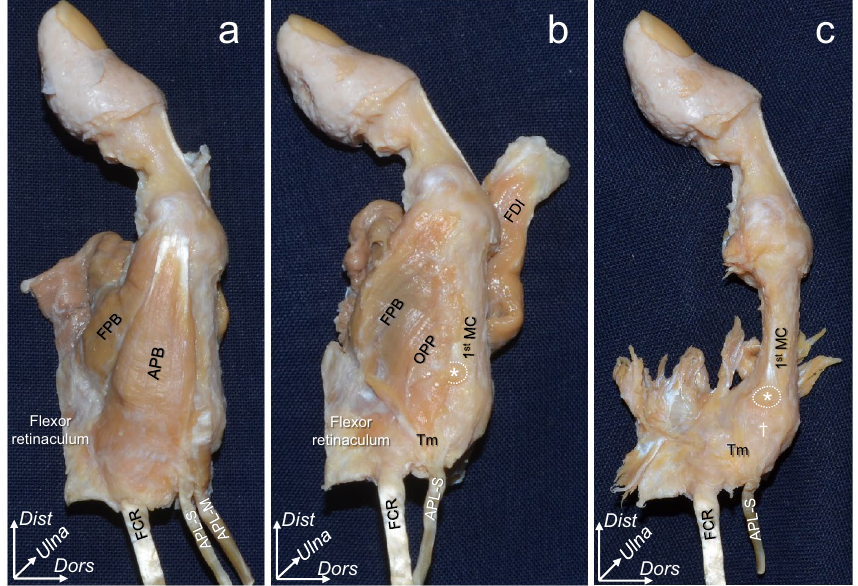
Figure 4. Macroscopic analysis of the radial aspect of the trapeziometacarpal joint. The photographs in Fig. 3 show the radial aspect (right thumb). The layered relationships among the abductor pollicis brevis (APB), opponens pollicis (OPP), flexor pollicis brevis (FPB), and joint capsule are indicated. ( a ) the radial side of Fig. 3b. ( b ) the APB and abductor pollicis longus main tendon (APL-M) are removed from ( a ). The attachment of the APL-M to the first metacarpal bone (1st MC) is indicated by an asterisk. ( c ) muscular parts of the FPB and OPP are removed from ( b ). The radial capsule in the deep layer of the FPB and OPP is indicated by a dagger. FCR, flexor carpi radialis; APL-S, abductor pollicis longus–supernumerary tendon; Tm, trapezium; Dist , distal; Dors , dorsal; Ulna ,